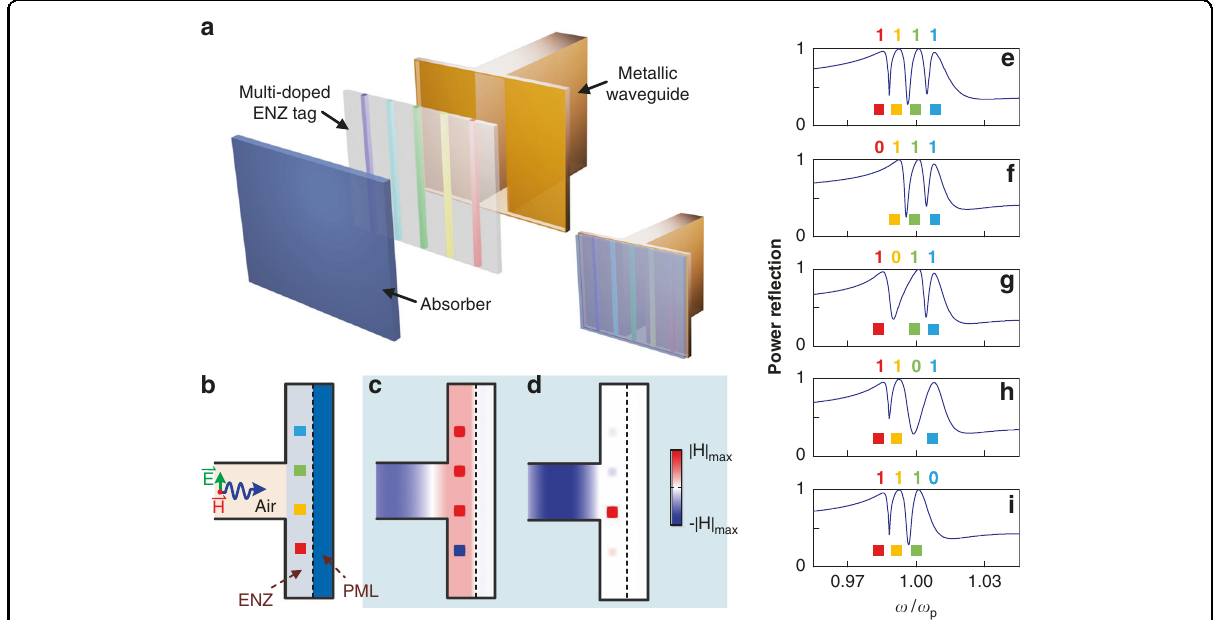
Fig. 6 Radio-frequency tagging based on dispersion coding in ENZ structure. a Schematic view of the proposed radio-frequency tag inspired by the ENZ-based dispersion coding. Inset: assembled tagging device. b The two-dimensional con fi guration of the proposed tagging device. The ENZ medium has an area of 0.25 λ p × 2.27 λ p ( λ p is the free-space wavelength at ω p , chosen as 2 π × 5.05 × 10 9 rad/s in this example), while four dopants shown have slightly different cross-sectional sizes of 0.117 λ p × 0.117 λ p , 0.117 λ p × 0.114 λ p , 0.117 λ p × 0.112 λ p , and 0.117 λ p × 0.110 λ p . A perfect match layer (PML) is used to emulate the absorber in numerical simulation. The snapshot of the simulation results of the magnetic fi eld distribution at ( c ) 0.985 ω p (a re fl ection dip) and ( d ) 0.991 ω p (a re fl ection peak). e The simulation results of re fl ection spectrum of the con fi guration shown in ( b ) with four dopants. The re fl ection spectra for the con fi guration shown in ( b ) yet with the red, yellow, green, or blue dopant being removed from the ENZ host are shown in ( f) , ( g) , ( h ), and ( i ),